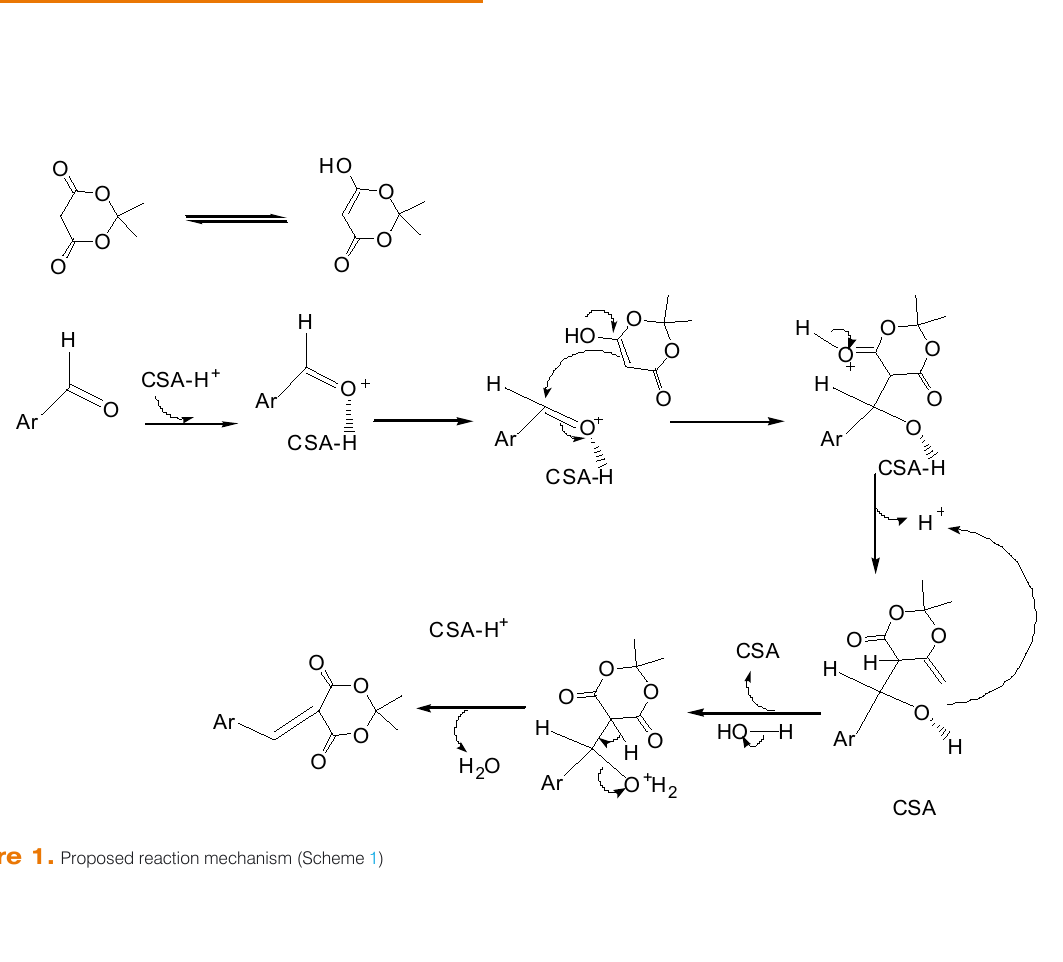
Figure 1. Proposed reaction mechanism (Scheme 1)